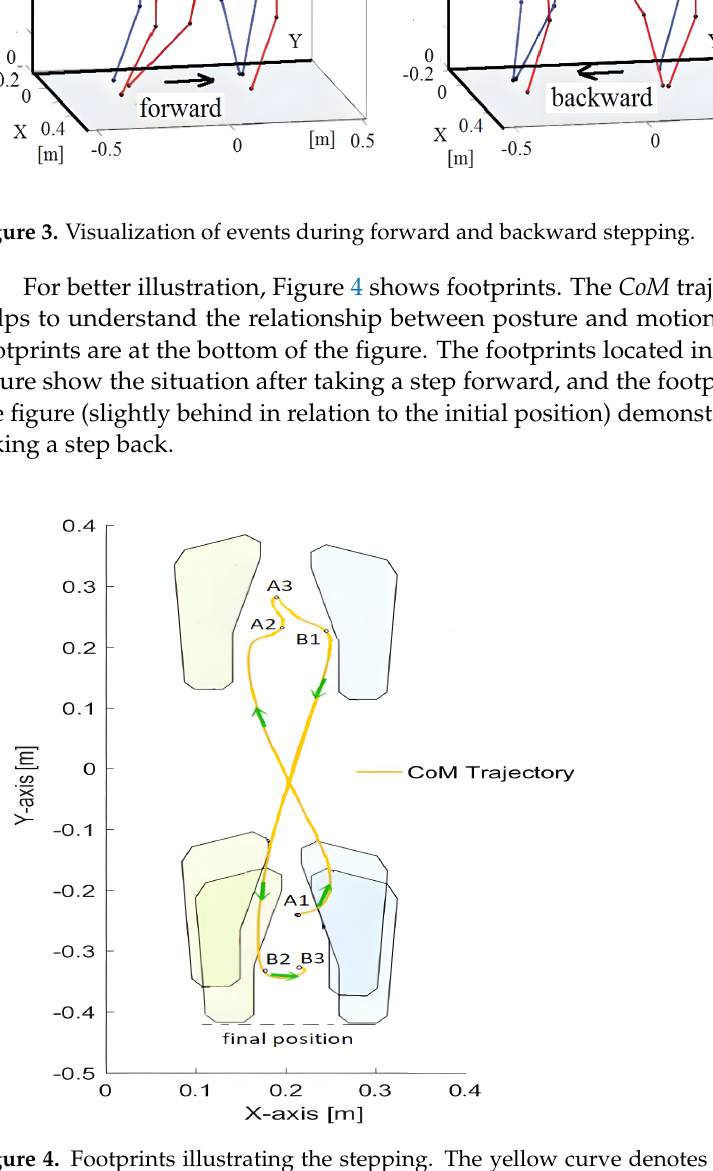
Figure 4. Footprints illustrating the stepping. The yellow curve denotes the CoM trajectory, and motion events are